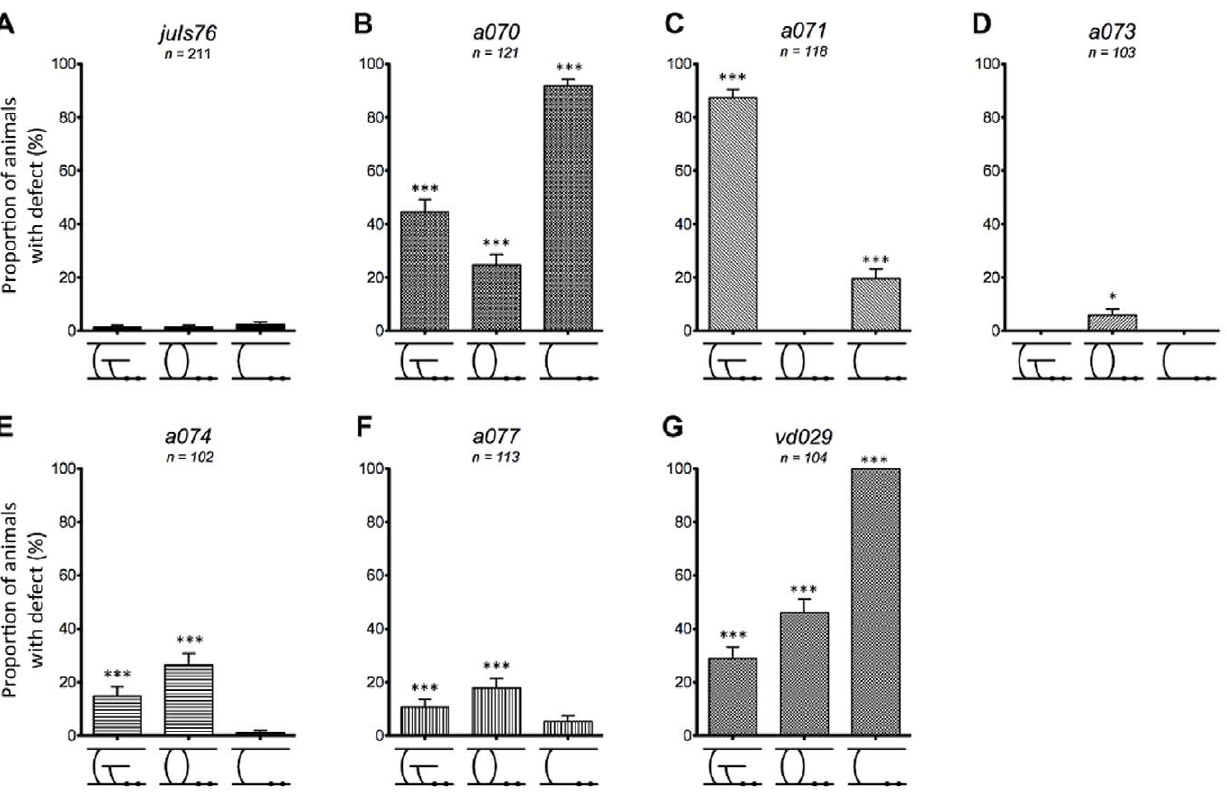
Figure 5. L1 phenotype characterization. (A–G) Proportion of animals in a population with at least one incidence of each of the independent defects: guidance, handedness, and missing defects seen for wild-type ( juIs76 ) and newly isolated mutants. Asterisks indicate statistical significance of phenotype compared to wild-type. Single, double, and triple asterisks indicate p , 0.05, p , 0.01, and p , 0.001 respectively. Statistical significance determined using chi-squared test. Number of animals examined for each allele labeled in graph. Error bars represent standard error of proportion.